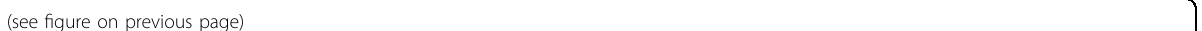
Fig. 3 HBV induced transcriptional changes in host cells with SIRT6 emerging as a potential host virus-restricting factor. a RNA-sequencing was conducted with Huh7.5.1 cells transfected with Vector (Control) or prcccDNA and pCMV-Cre. Heatmap of 11 transcriptional DEGs, which have transcription corepressor activity, three biological replicates were shown for HBV and control group. b RT-qPCR con fi rmed that HBV downregulated the transcriptional level of endogenous SIRT6 transcription. c Network analysis of SIRT6-associated genes whose transcription was altered by HBV. Red and blue nodes indicate the upregulated and downregulated genes, respectively. The color intensity indicates the fold change level of the gene. Nodes with * are DEGs ( P -adjust <0.05, |log 2 FC| ≥ 1, also see methods). d RT-qPCR validation of some of the SIRT6-associated genes that were shown in c . e Representative pro fi les of ribosome footprints of human SIRT6 ORF upon HBV, translation initiation of endogenous SIRT6 was downregulated by HBV in Huh7.5.1 cells. The highest read count was set as 1 and the read counts of other groups were normalized to this group. f Endogenous SIRT6 was downregulated by HBV in Huh7.5.1 cells. g De novo infection of HBV downregulated endogenous SIRT6 level in HepG2-NTCP cells, HepG2 cells stably expressing NTCP (sodium taurocholate cotransporting polypeptide), the functional receptor of HBV. The results of two independent biological replicates were shown. h HBV downregulated SIRT6 in mouse livers infected with adenovirus harboring HBV genome. i Total proteins were extracted from the normal liver tissues of 12 patients who were diagnosed with HBV positive and negative, respectively. For patient information see Supplementary Table S1. Endogenous SIRT6 or GAPDH proteins were visualized with IB using anti-SIRT6 or anti-GAPDH, with their relative abundances calculated using ImageJ. j The reverse correlation between the serum levels of HBsAg and the relative abundances of endogenous SIRT6 protein in liver tissues of the 12 patients. * P < 0.05, ** P < 0.01, *** P < 0.001. qPCR results are presented as bar chart (For SIRT6, n = 2; for other genes, n = 3); ELISA data are presented as bar chart ( n =